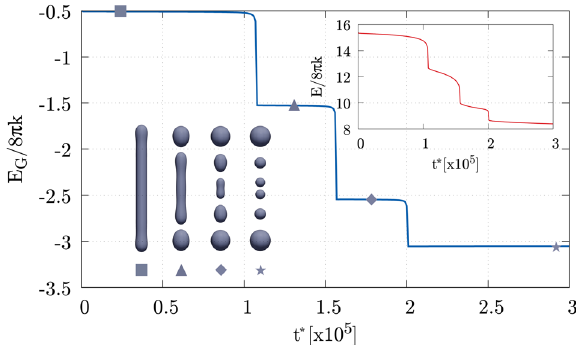
Fig. 1 Free energy evolution example. The phase- fi eld Gaussian energy E G during a series of scissions of a prolate shape into several spheres (main plot, blue line), where symbols identify the shown vesicle con fi gurations. The energy jumps by − 4 π k for any division as prescribed by the Gauss – Bonnet theorem ( k = − k G ). The fi ssion process occurs due to the presence of a spontaneous curvature m * ≈ 0.42. Time evolution is given by the Allen – Cahn gradient fl ow with M * = 8 (see the section “ Methods ” for more details on the dynamics, the adopted numerical scheme, and dimensionless quantities). The inset shows the total energy E = E B + E G , which monotonically decreases in time, revealing the stability of the scheme. This z -axial symmetric simulation has been carried out in a [0, 36] × [0, 440] computational domain in the r * − z * plane with a ¼ 1 = λ (cid:6) 109 and d t * = 4. There is no constraint 54 × 660 mesh, initial D (cid:5) ve on the area, which, at the end of the simulation, differs from the initial value by ~6.9%. Volume is conserved with a relative error smaller than 10 − 7 with respect to its initial